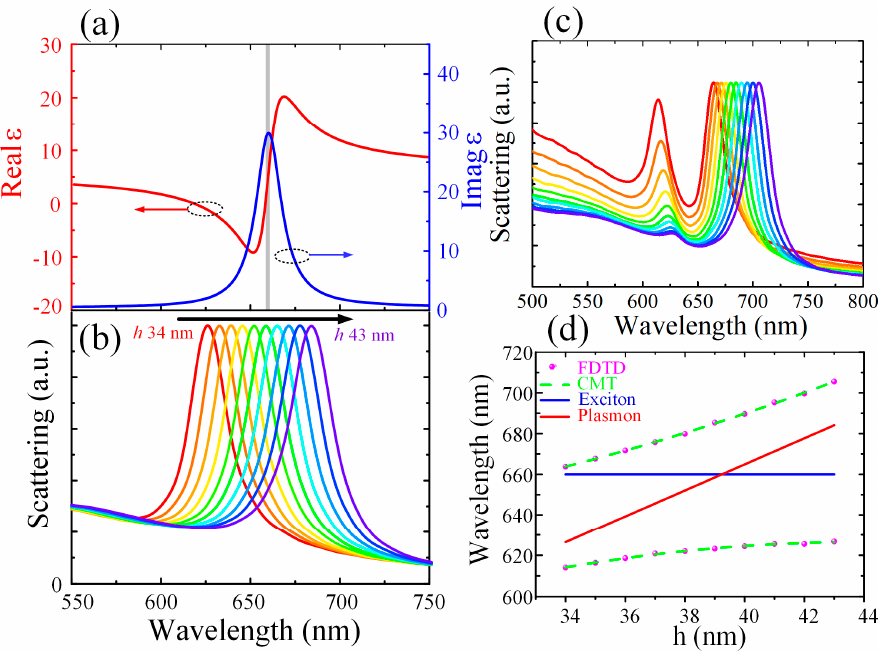
Figure 5. ( a ) The real (red line) and imaginary (blue line) parts of the relative permittivity of the single QD used in this work. ( b ) Simulated scattering spectra for different thicknesses h of the silver nanoantenna placed on the silver film. ( c ) Simulated scattering spectra for different thicknesses h of the silver nanoantenna coupled with the single QD in the nanogap. ( d ) The resonance of the two new coupling states as the silver nanoantenna thickness h varies. The purple dots and green dashed curve correspond to the FDTD simulation and the CMT results, respectively. The blue and red curves stand for the individual resonances of the exciton and the plasmon modes, respectively.